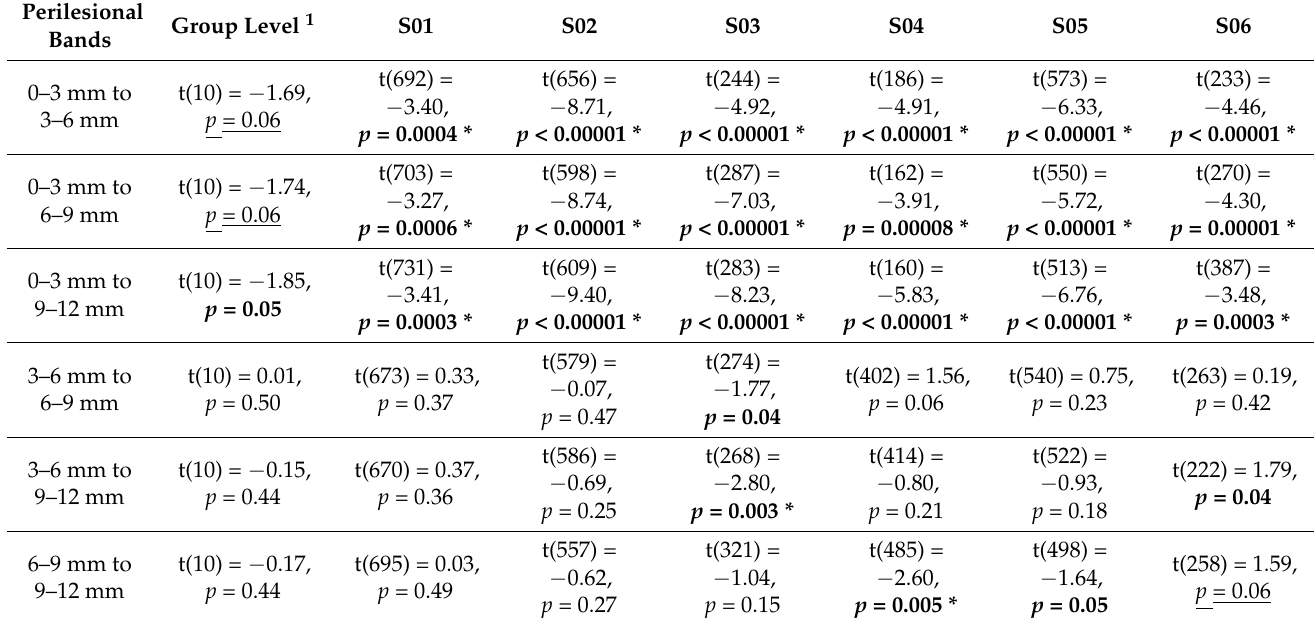
Table A3. Comparisons of CBF patterns at each perilesional band for group and individual levels. 1 Group-level analyses were conducted with mean CBF values across all participants. Underlined p -values reflect trends at the p < 0.06 level. Bolded values are significant at p < 0.05. * indicates that the p -value survived Bonferroni correction at p <